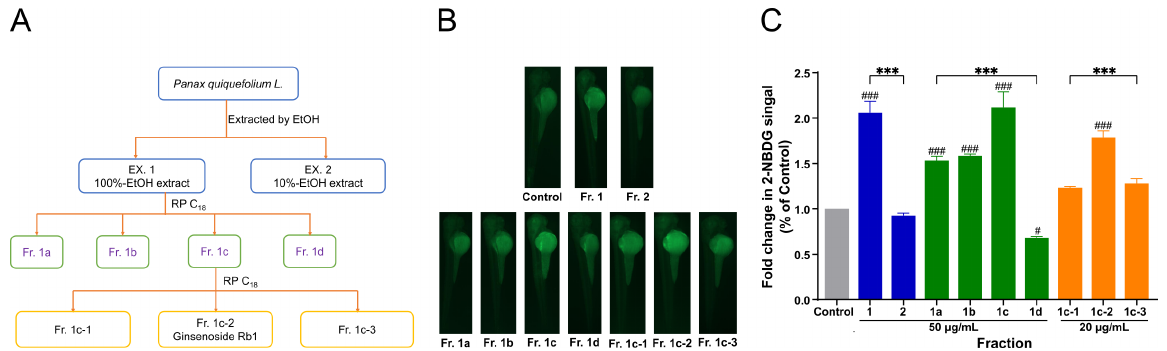
Figure 1. Bioguided separation of the active ingredients in American ginseng. ( A ) Scheme of bioguided fractionation. ( B , C ) Fluorescence microscopy images of zebrafish larvae after treatment with different fractions and the fold change in absorption of 2-NBDG quantified by Image J. Blue, green and orange are three different batches. Results are expressed as mean ± SEM. ### p < 0.001, # p < 0.05 vs. control. *** p < 0.001.